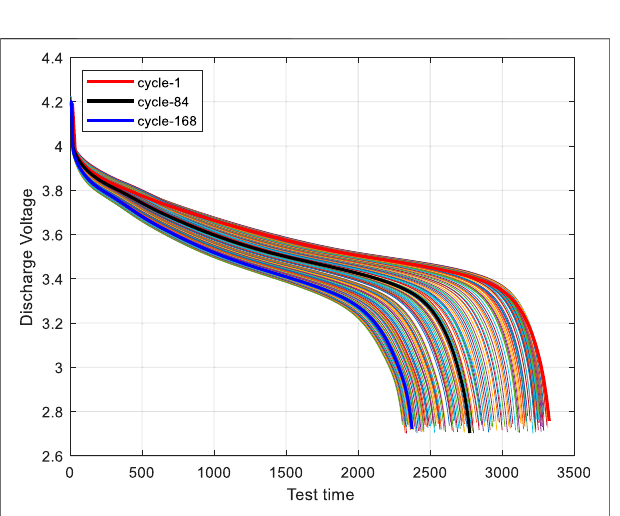
FIGURE 4 | Battery SOH online prediction process based on PSO-SVM.